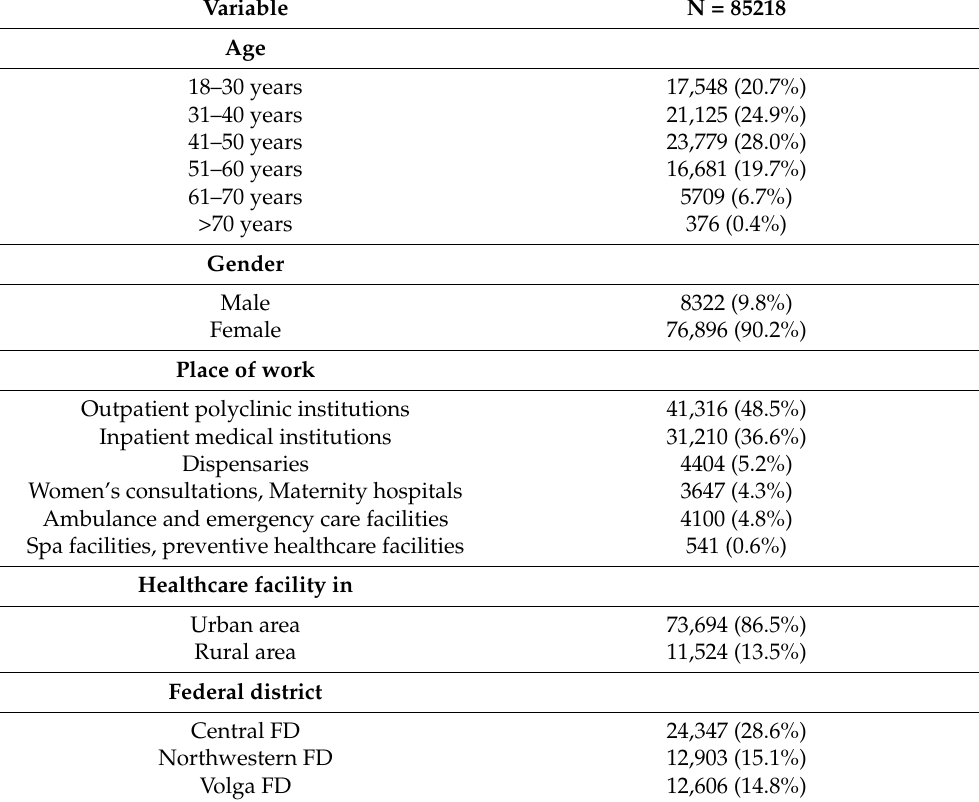
Table 1. Demographic